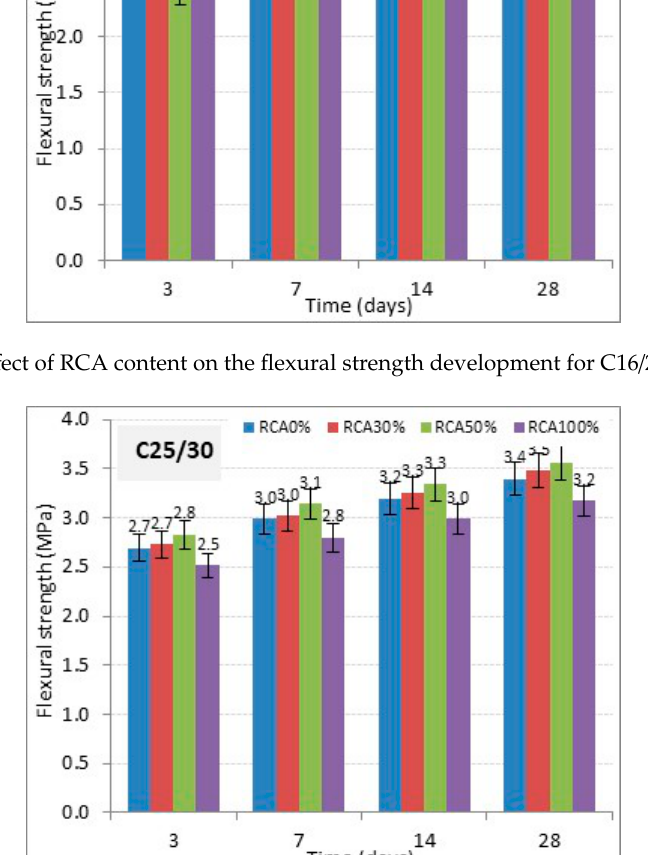
Figure 10. Effect of RCA content on the flexural strength development for C25/30 concretes. Figure 10. E ff ect of RCA content on the flexural strength development for C25 / 30